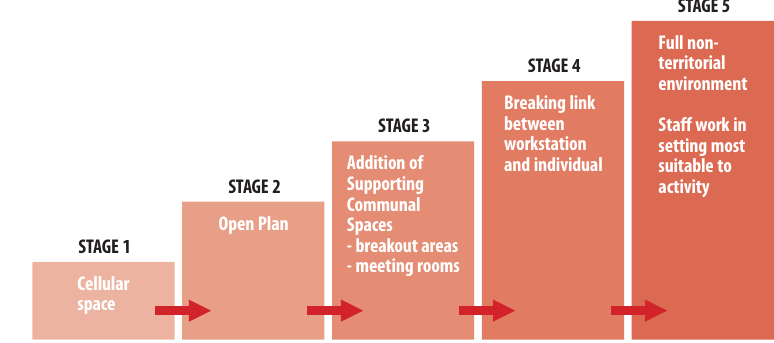
Figure 2. Evolution stages of fl exible